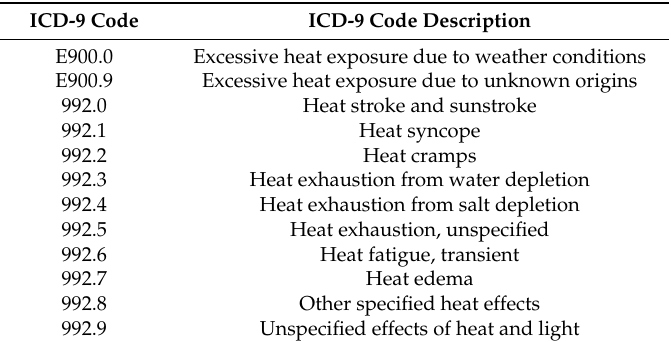
Table 2. ICD-9 codes used to determine heat-related morbidities from inpatient hospitalization and emergency department billing